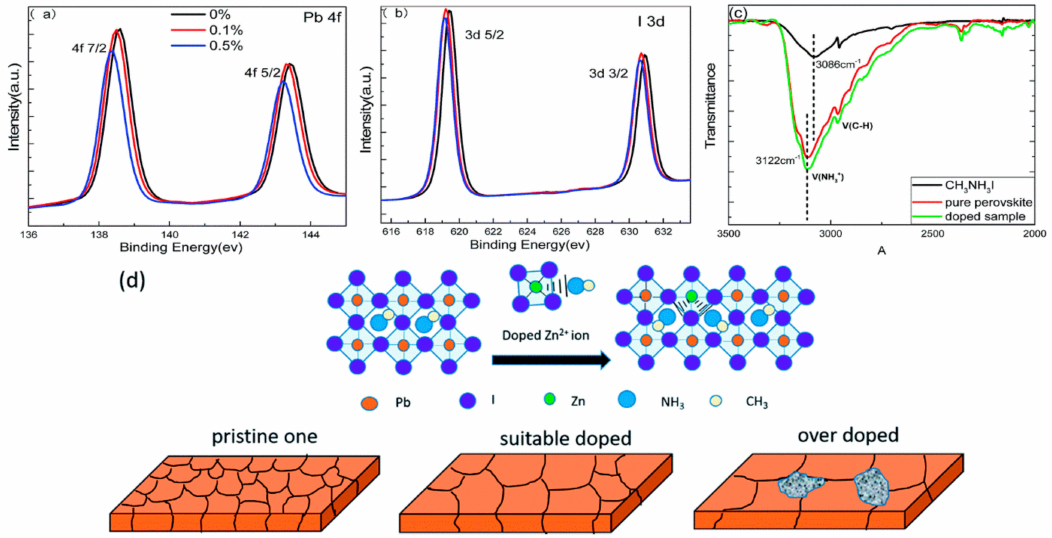
Figure 7. Binding energies of Pb 4f ( a ) and I 3d ( b ) which diminish upon increase of Zn 2 + content. ( c ): Stretching vibration of the NH 3 + group in pristine CH 3 NH 3 I and in perovskite. ( d ): Schematic representation of the lattice in which Zn 2 + is incorporated. MA(Pb:Zn)I 3 -[Cl − ]. Reproduced from Sustain. Energy Fuels 2018 , 1093–1100, with permission from The Royal Society of Chemistry. Figure reprinted from Reference